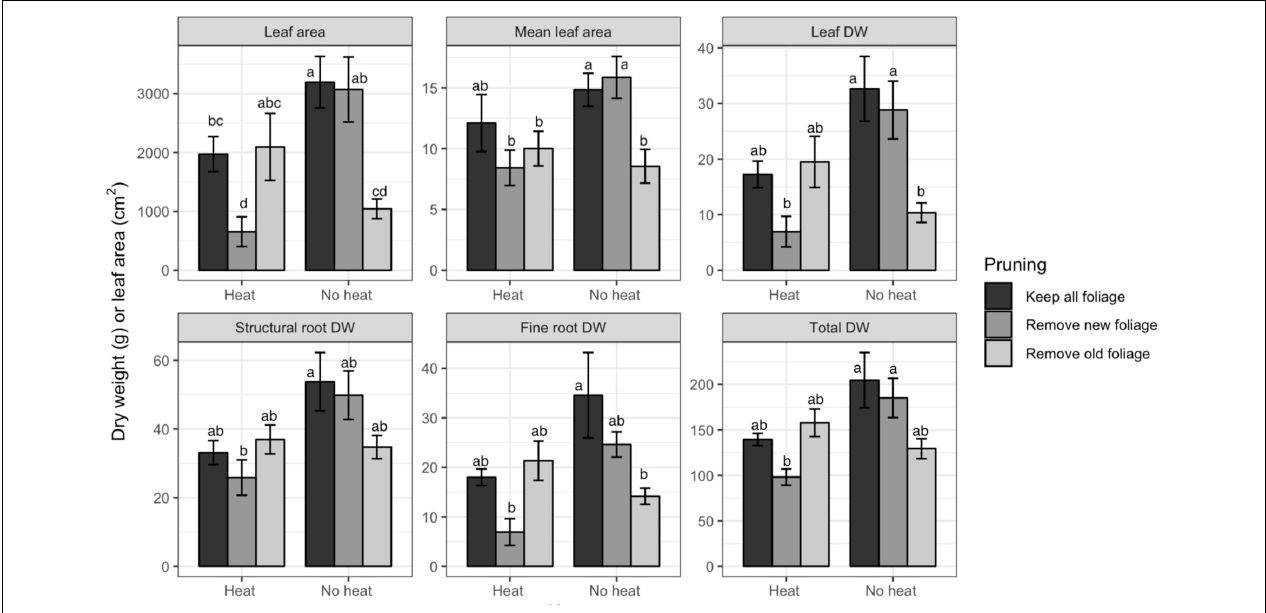
FIGURE 2 | Dry weights (DW) and leaf area of various organs of Valencia/X-639 citrus plants upon termination of Trial 1, 81 days after heat treatment. Shaded bars represent means, and error bars represent standard error ( n = 6). Bars labeled with different letters indicate significant differences at P < 0.05 using Bonferroni’s protected